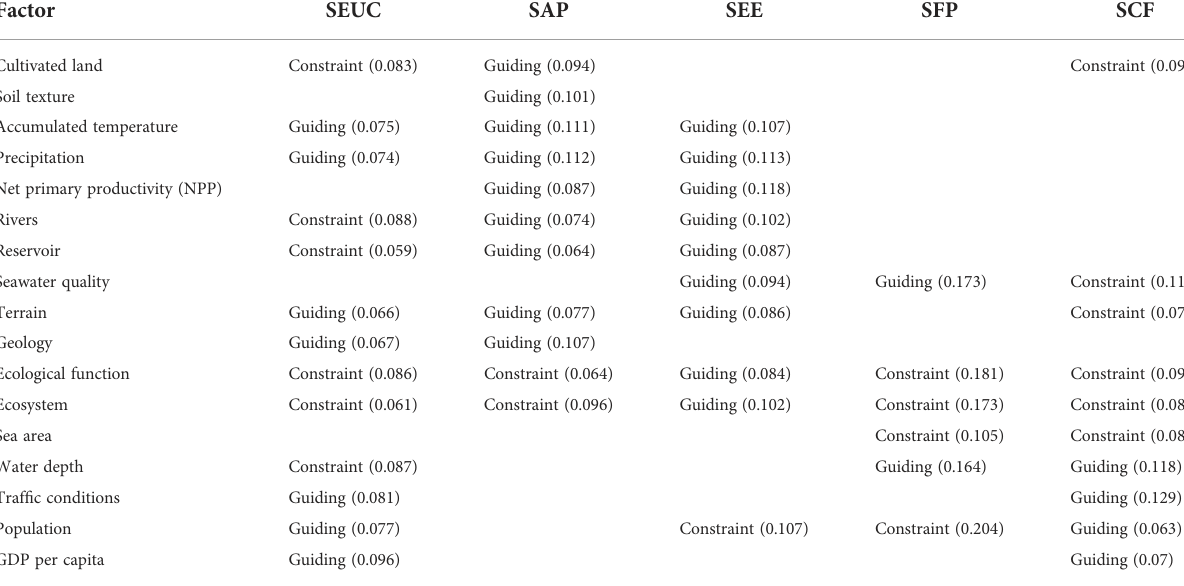
TABLE 2 Coastal zone spatial suitability evaluation index